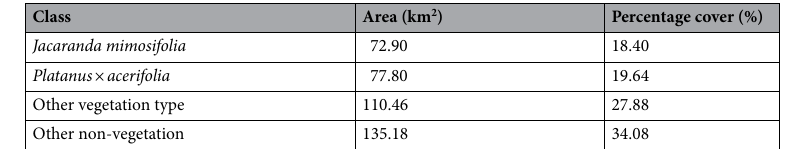
Table 3. The percentage cover of the Jacaranda mimosifolia, and Platanus × acerifolia (London Plane) in the city of Johannesburg, South Africa.